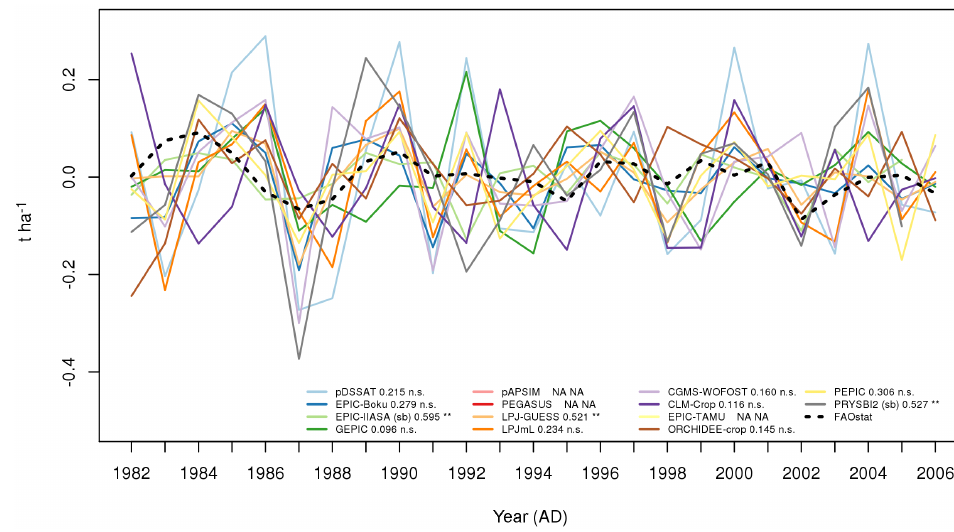
Figure 3. As Fig. 1 but for rice. EPIC-TAMU, PEGASUS and pAPSIM did not supply data for rice.